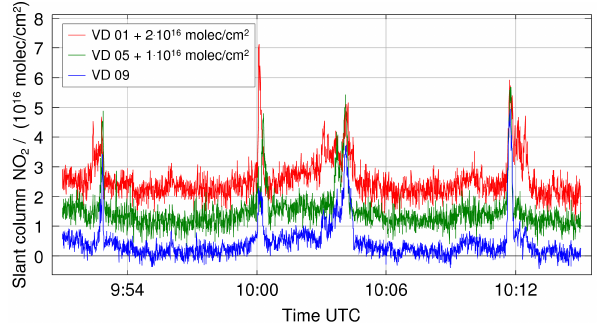
Figure 6. Excerpt of the NO 2 time series measured at high tem- poral resolution (0.5s exposure time) during the flight on 4 June 2011, here for three of the nine viewing directions, VD01, VD05 and VD09, offset against one another for better visibility. Signif- icant spatial variation of NO 2 amounts is visible along the time axis (along track) as well as between the single viewing directions (across track).